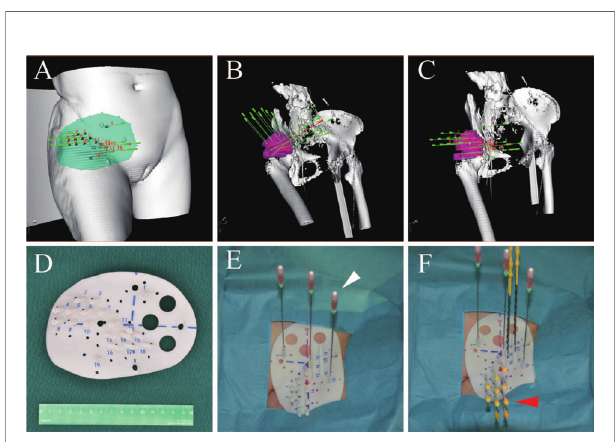
FIGURE 1 | The design of 3D-PNCT based on CT-simulation for a patient with recurrent ovarian cancer. (A) The 3D digital model of 3D-PNCT. (B, C) Design the optimal puncture paths and needles angle on 3D digital model. (D) The real product of 3D-PNCT contains cooridinate axis for alignment, holes for stable needle and puncture needle. (E, F) The immoblized 3D-PNCT with stable needles (white arrow) and catheters (red arrow) before 125I seeds implantation. 3D-PNCT, three-dimensional printing non-coplanar